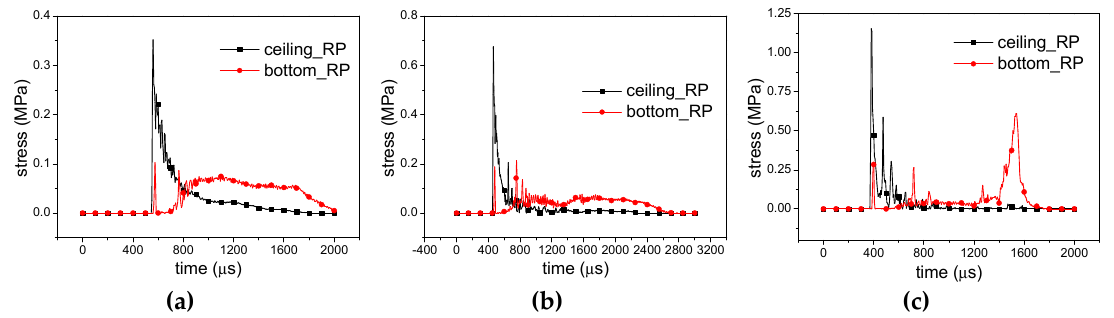
Figure 14. Stress-time curves of X1 -RP-H-RP; ( a ) Overall response mode; ( b ) Transitional response mode and ( c ) Local response mode.